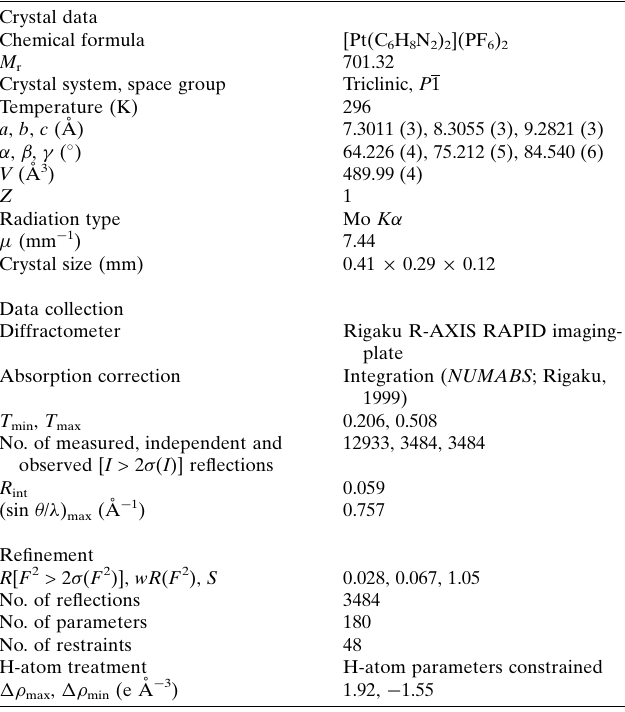
Table 2 Experimental details. Crystal data Chemical